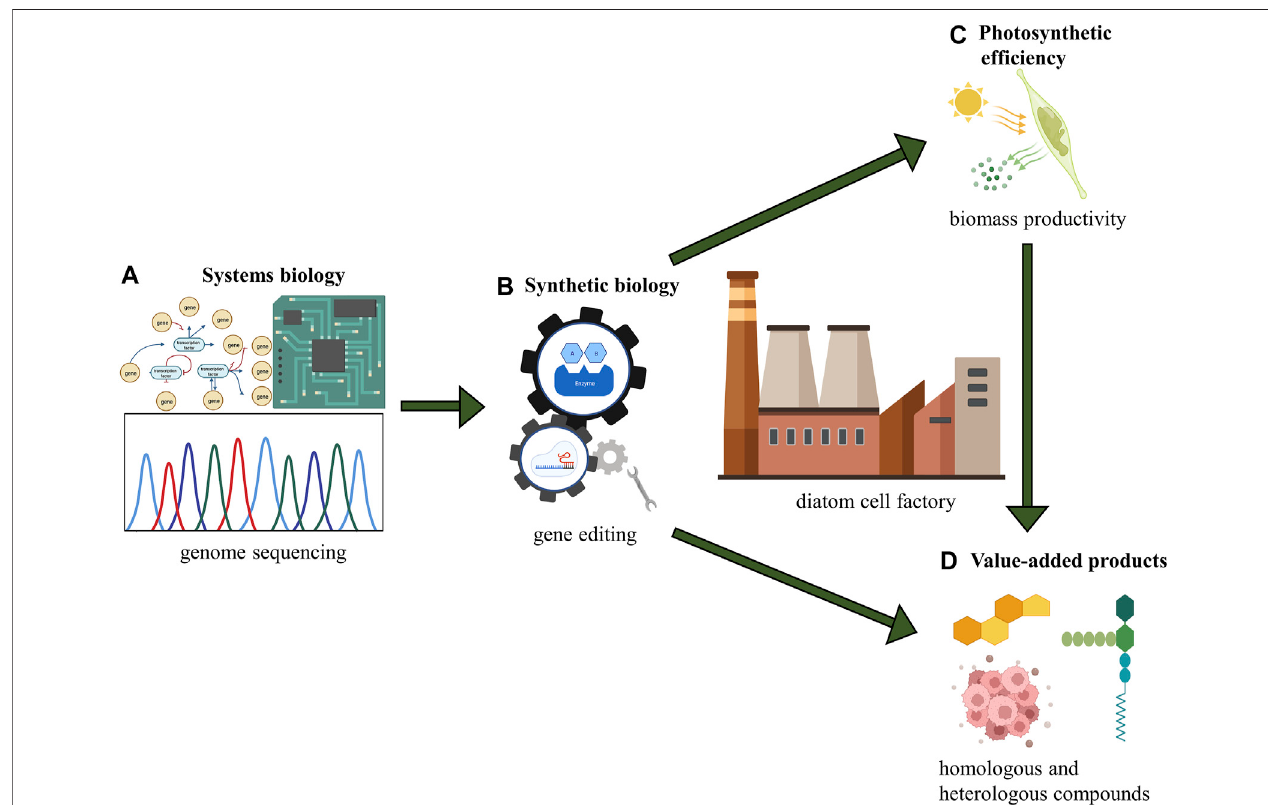
FIGURE 4 | Conceptual scheme for diatom cell factory. (A) systems biology: understanding the whole picture of metabolism in diatoms; (B) synthetic biology: genetic manipulation and genome engineering; (C) photosynthetic ef fi ciency: fundamental principle of energy conversion and biomass production; (D) value-added products: output from diatom cell factory including homologous and heterologous